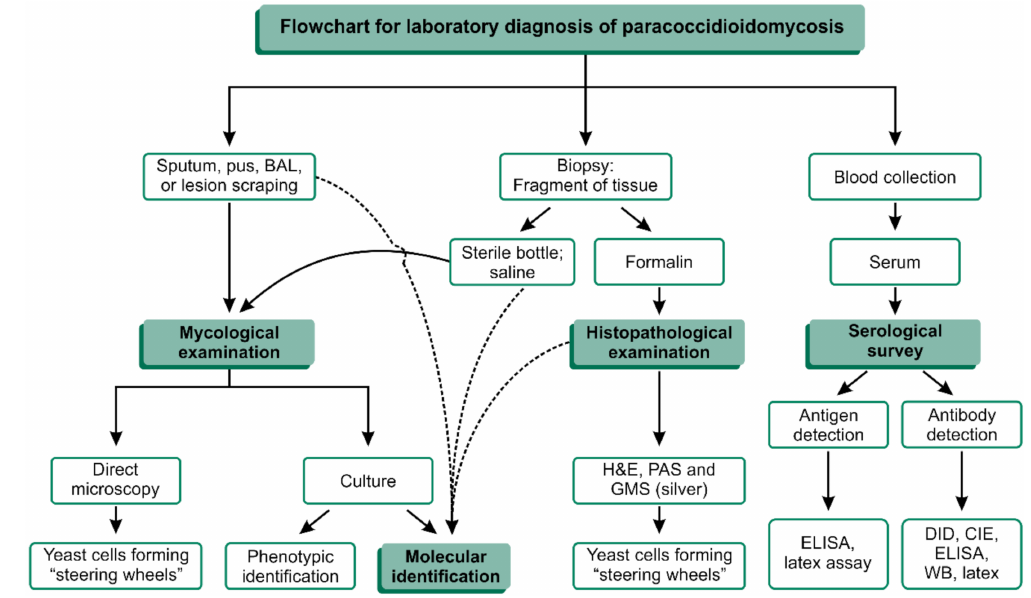
Figure 3. Flowchart for laboratory diagnosis of paracoccidioidomycosis (PCM). BAL: Bronchoalveolar lavage; H&E: Hematoxylin and eosin staining; PAS: Periodic acid–Schiff; GMS: Gomori methenamine silver; ELISA: enzyme-linked immunosorbent assay; DID: double immunodiffusion; CIE: counterimmunoelectrophoresis reaction; WB: Western